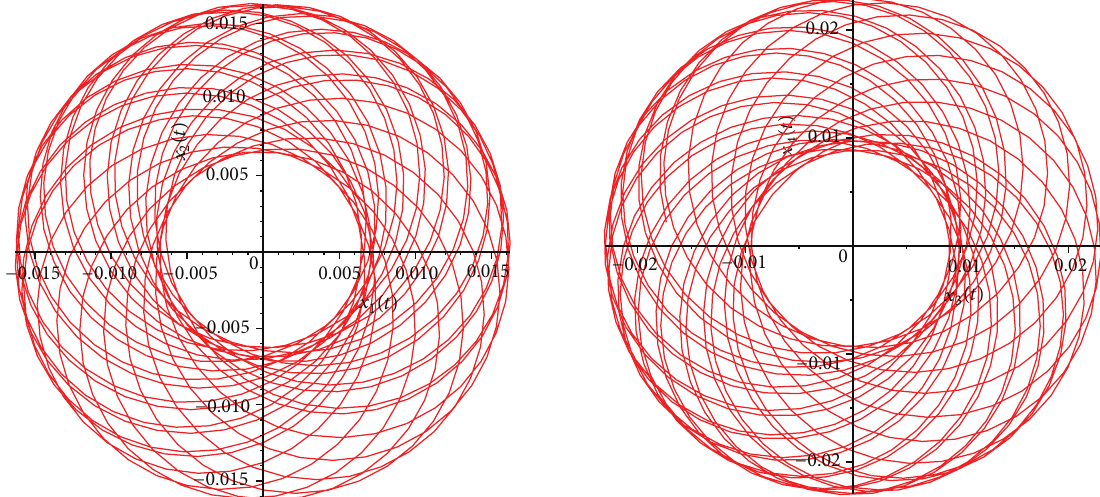
Figure 10: A two-dimensional torus starting from (𝑥 1 , 𝑥 2 , 𝑥 3 ,𝑥 4 ) = (0,0.01, 0,0.01) when (𝜉 1 ,𝜉 2 ) = (−0.1,0.1) .